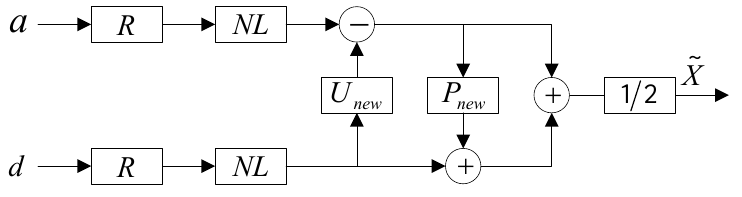
Figure 6. Block diagram about node-signal single-branch reconstruction of improved nonlinear redundant lifting wavelet